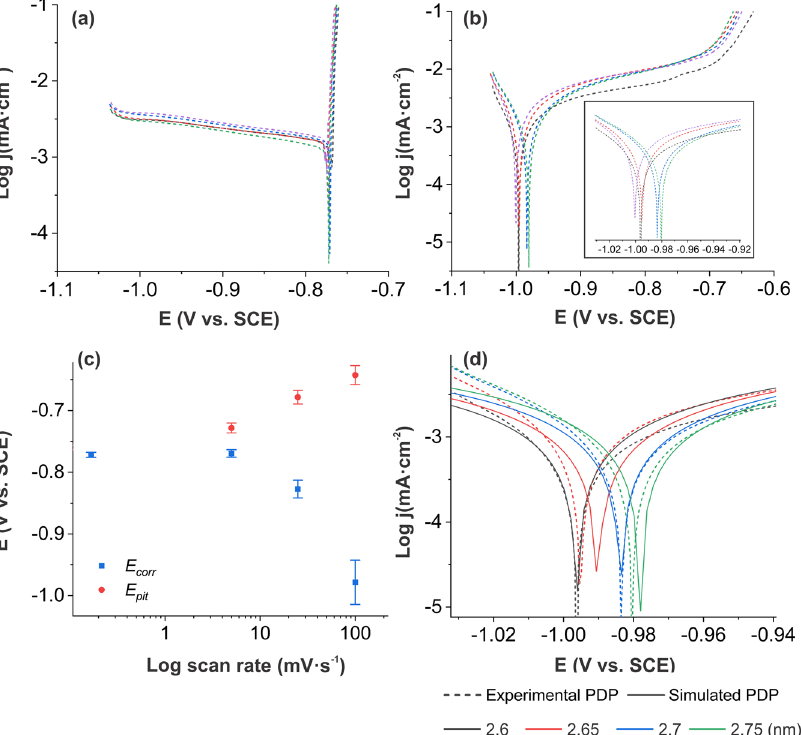
Fig. 9 Effect of scan rates on the variance between PDP replicates in 3.5 wt% NaCl. a 5 PDP replicates at 0.167 mV·s − 1 . b 5 PDP replicates at 100 mV·s − 1 , the inset shows an enlargement of the E corr region. c Distribution of the E corr and E pit at scan rates of 0.167, 5, 25, and 100 mV·s − 1 . Error bars represent the standard deviation of data of 5 replicates at each scan rate. d Simulated effect of air-formed oxide thickness, d 0 , and comparison with PDP replicates measured at 100 mV·s − 1